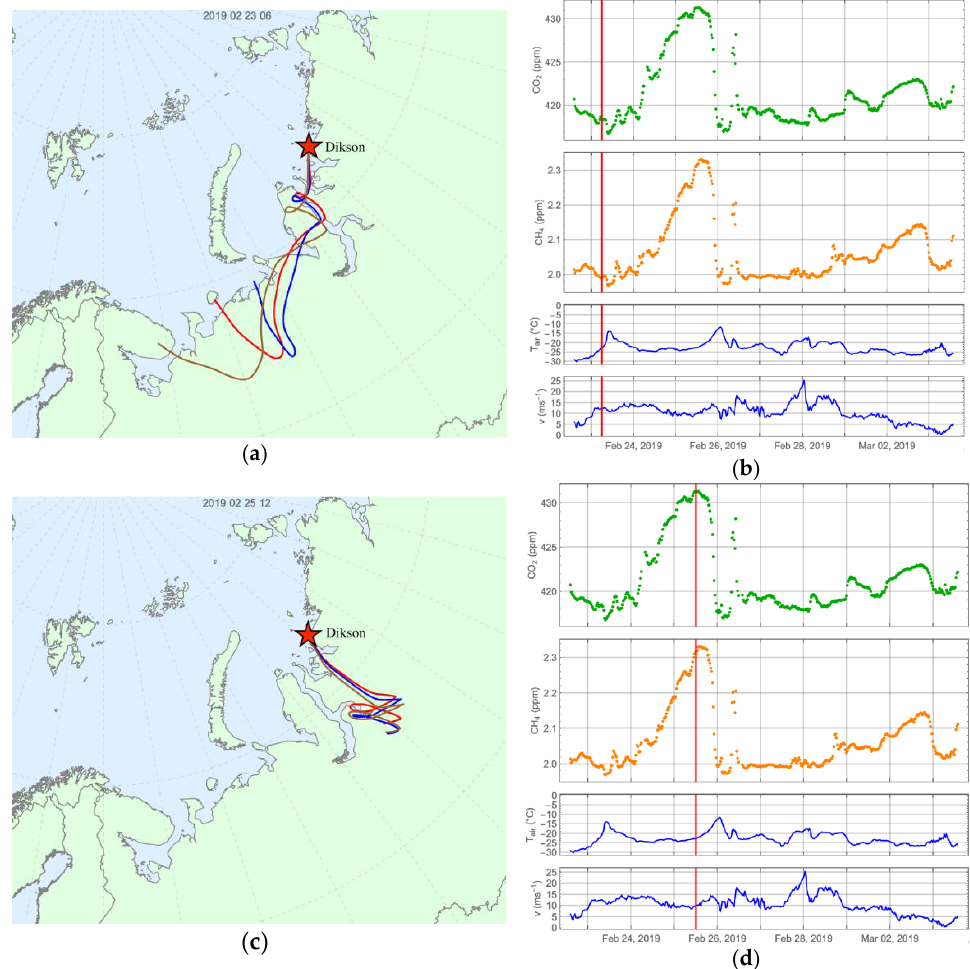
Figure 11. Atmospheric mole fractions of CO 2 , CH 4 , air temperature and wind speed records (30-min averages) ( a – c ) plotted together with 5-day backward trajectories ( b – d ) for the period of the winter pollution anomaly. A vertical red line indicates a time when the backward trajectory starts.